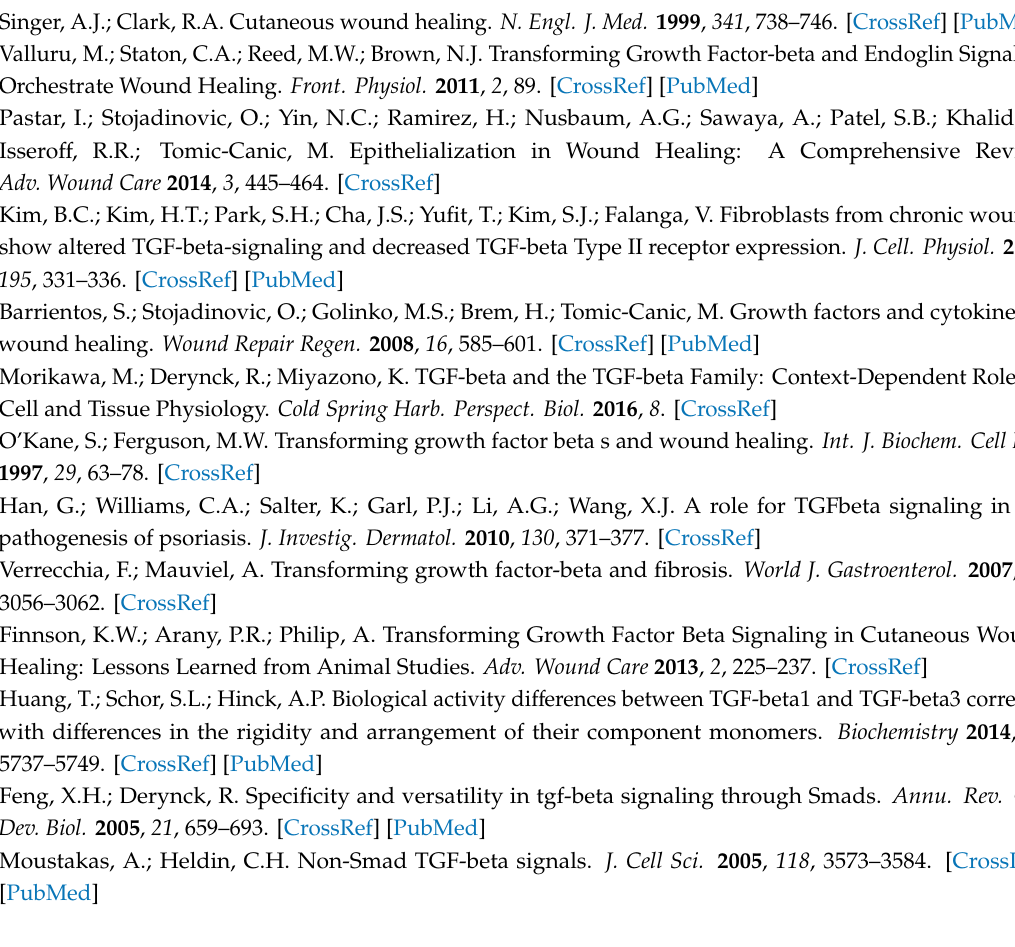
Table S1 : List of primers used for real time PCR studies.; Table S2. Apoptosis assessment. HaCaT cells were maintained either in full medium (FM) or serum deprived conditions (SS), in the absence or presence of TGF- β 1 for the indicated time. Data represent percentage of combined early and late apoptotic cell fractions from three independent experiments ± SEM; Figure S1 : Continuous TGF- β 1 stimulation does not induce Vimentin filaments in HaCaT cells.; Figure S2 : Acute TGF- β 1 treatment induces cell cycle arrest to HaCaT